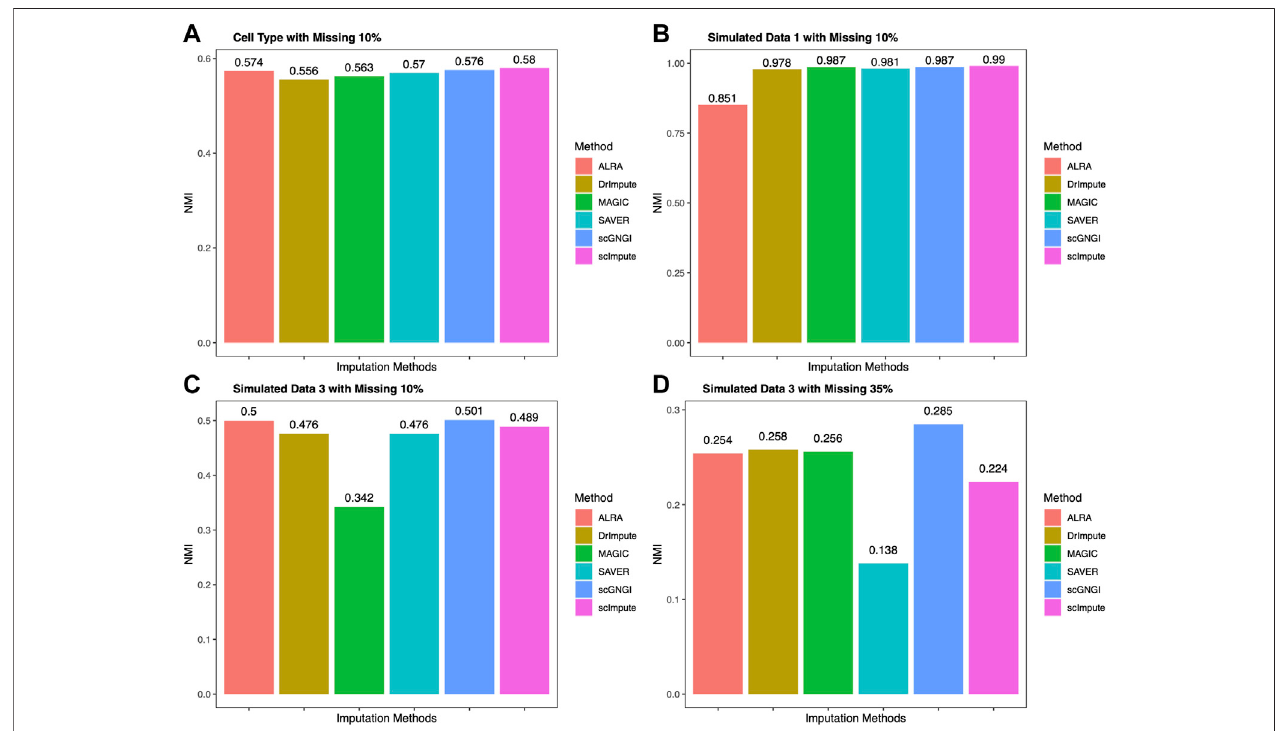
FIGURE 6 | Clustering performance on four scRNA-seq datasets. The results of K-means clustering are measured by the Normalized Mutual Information (NMI) on real and simulated data using different imputation methods.